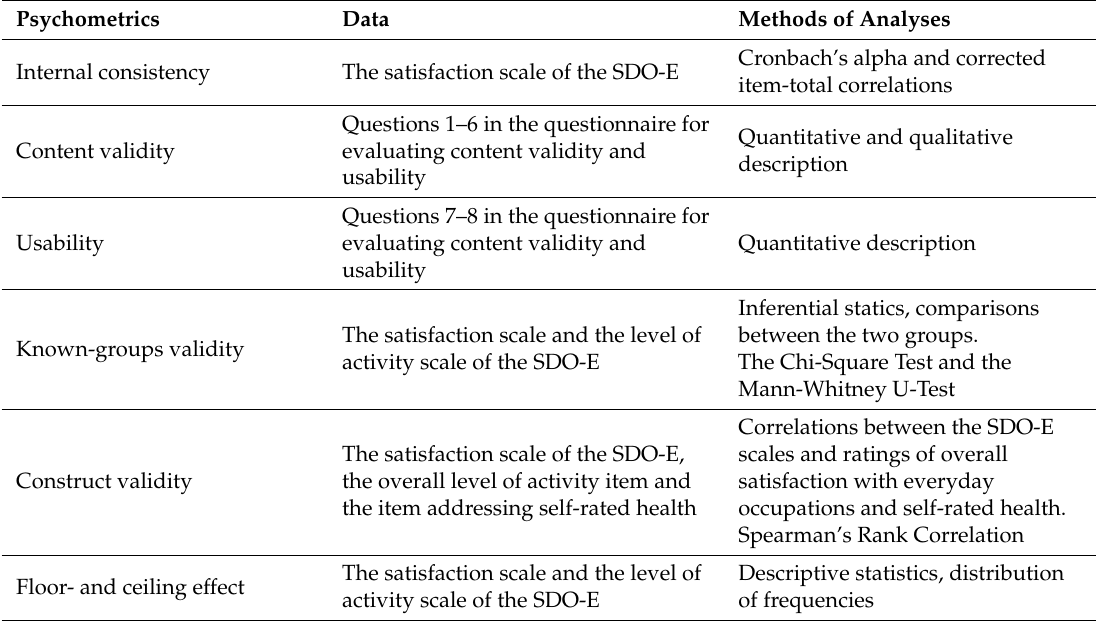
Table 2. Psychometric analyses and